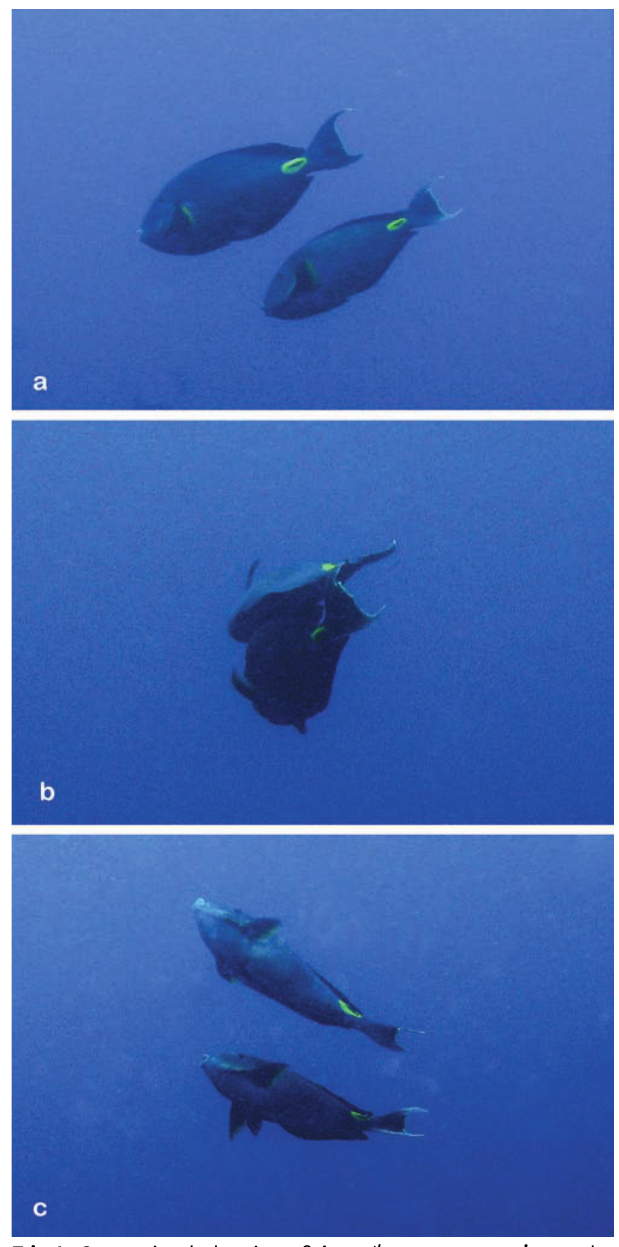
Fig.1. Spawning behavior of Acanthurus monroviae at the Laje de Santos Marine Park, Southeastern Brazil. Two individuals swimming side by side, the male (right) displaying to the female ( a ); the male rolling under the female, both of them in belly contact ( b ), and breaking away ( c